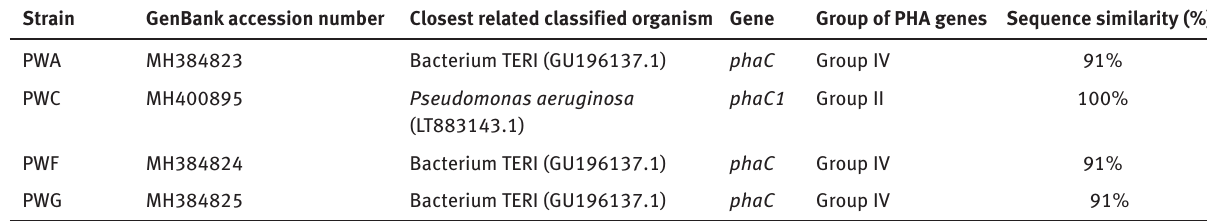
Table 2: Sequencing of gene phaC in produced water isolates.